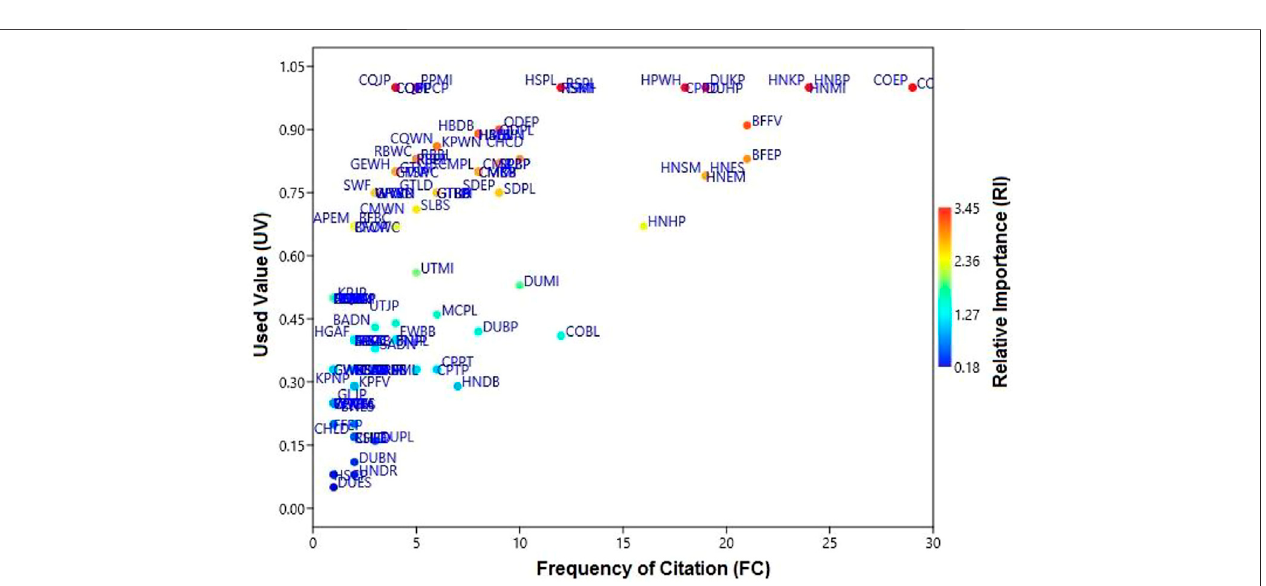
FIGURE 8 | Relationship between the frequency of citation (FC), use value (UV), and relative importance (RI) for a particular disease (UV). Codes represent the species names of birds that appear in Supplementary Table S1 .